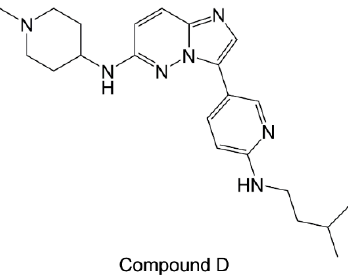
Figure 14. Chemical structure of compound D [116].